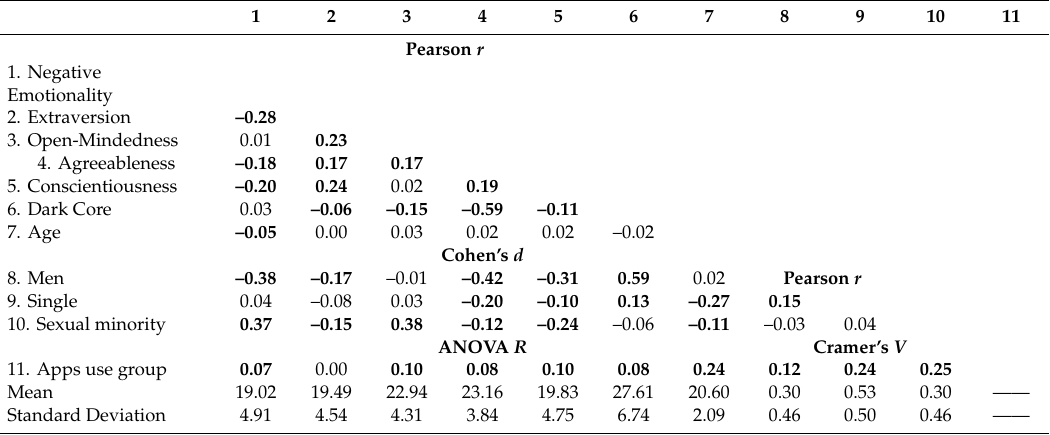
Table 1. Bivariate relations of the di ff erent variables and descriptive statistics.